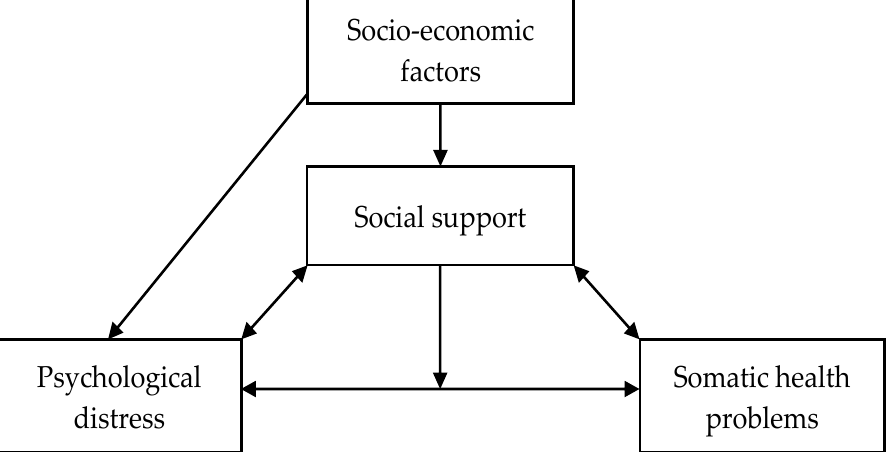
Figure 2. Conceptual model of the relationships between social support, psychological distress, somatic health problems and socio-economic factors.